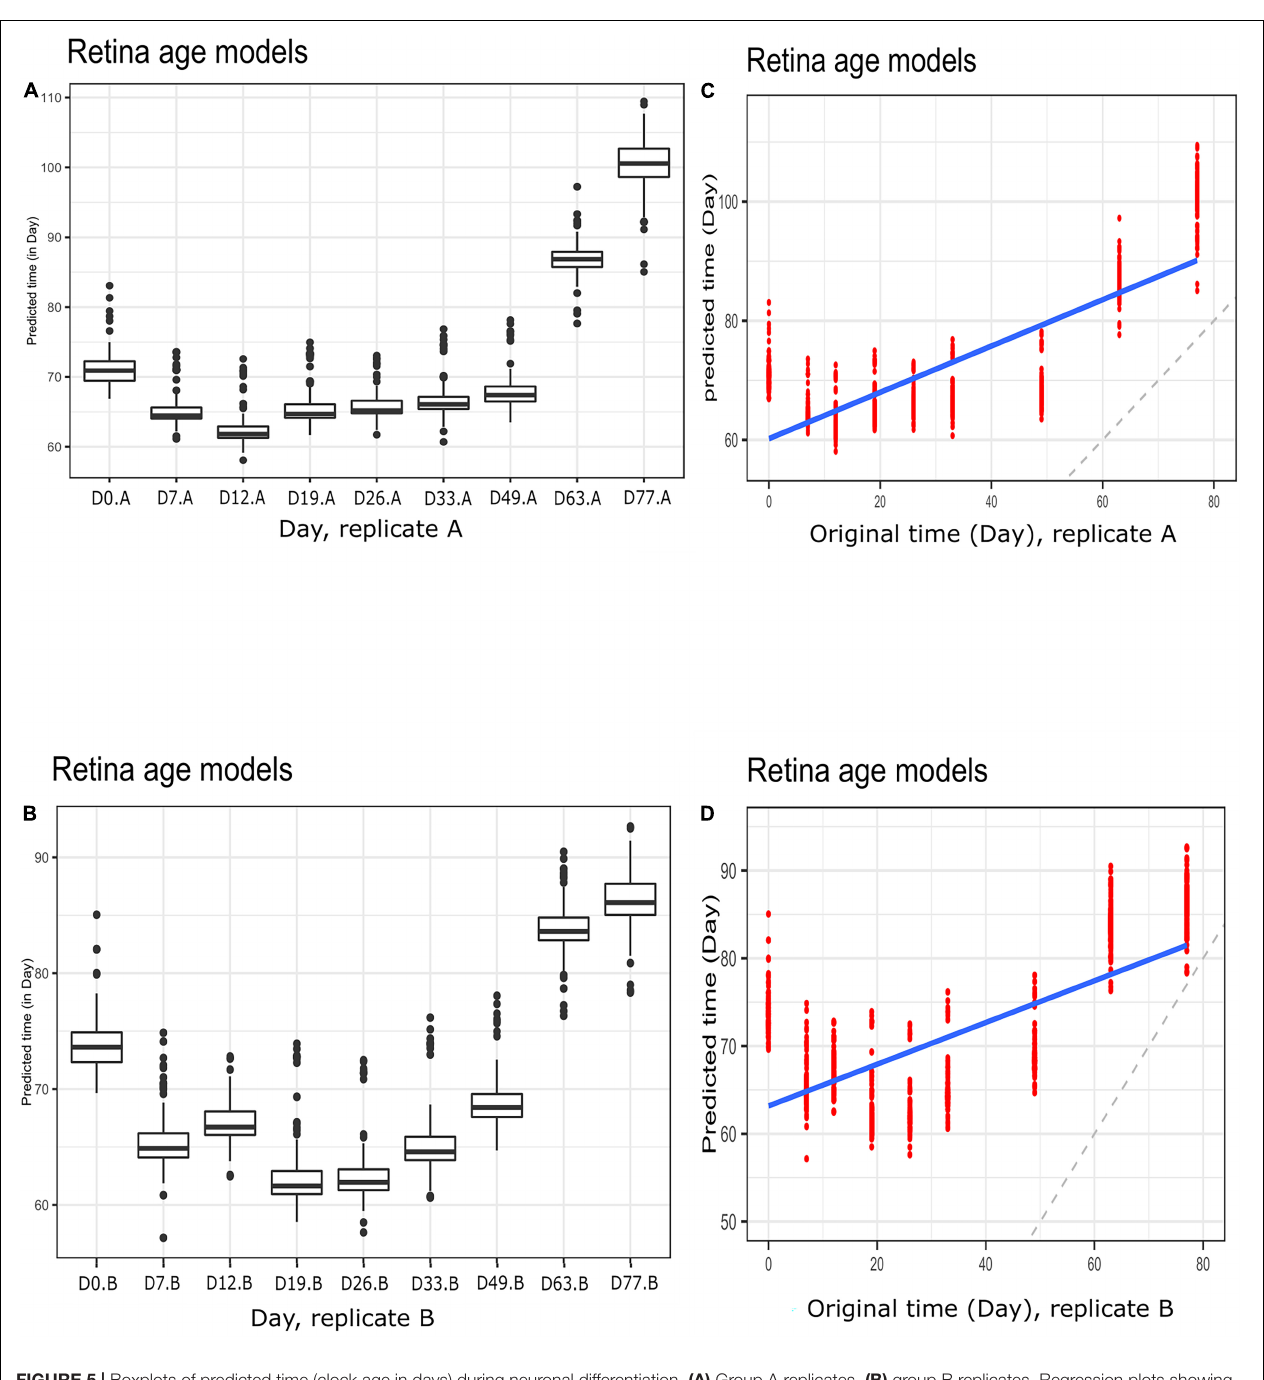
as in vitro neuronal differentiation suggests new opportunities for broader